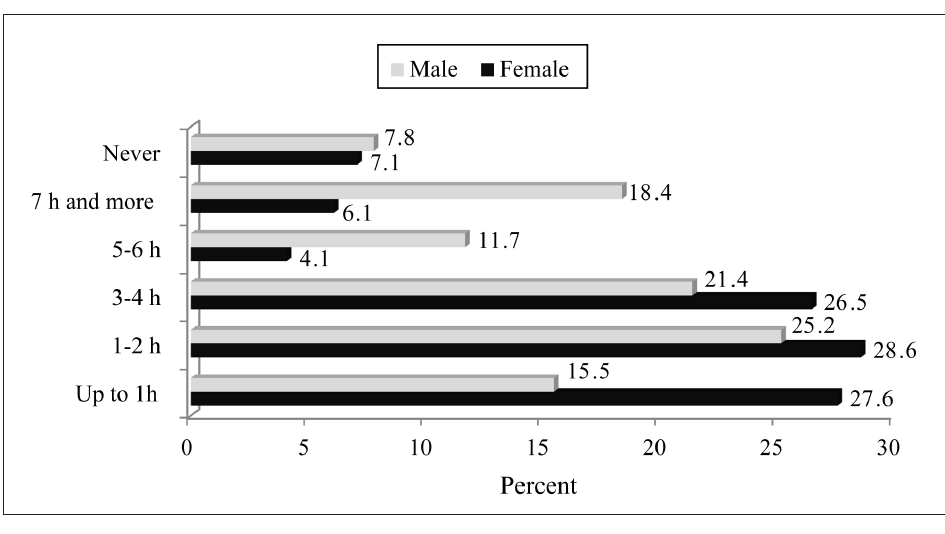
Figure 2. Time (hours per week) spent by students for indivi- dual exercising and